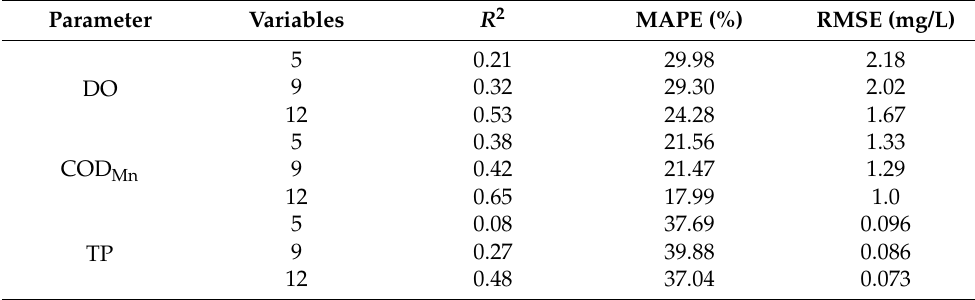
Table 5. Performance metrics of XGBoost model using three combinations.